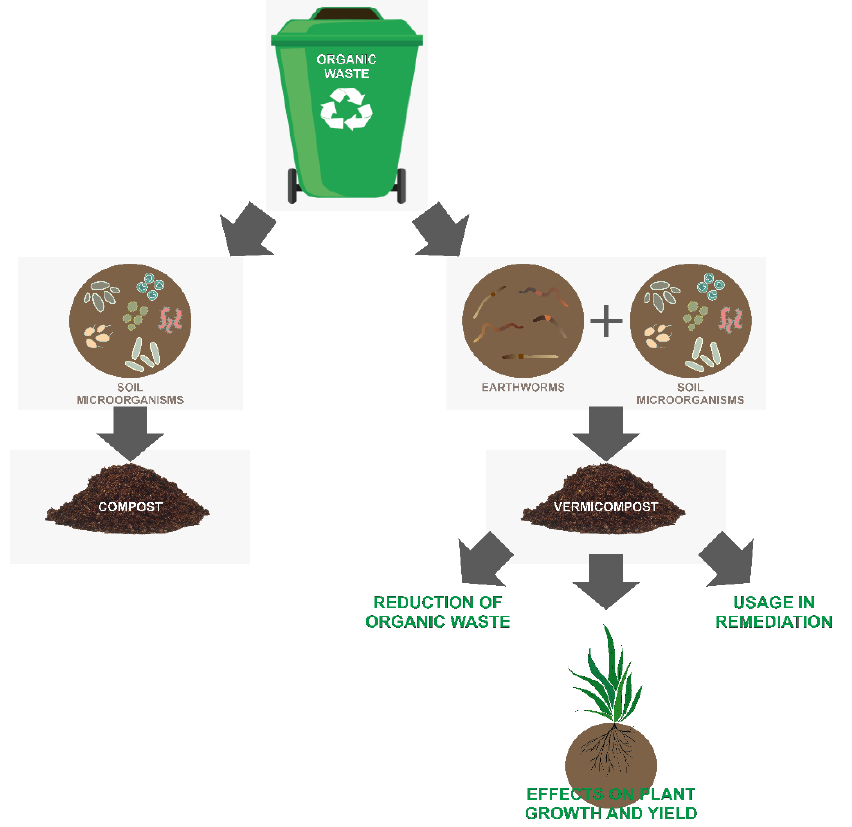
Figure 1. Conversion of organic waste into compost and vermicompost and the potential uses of vermicompost.